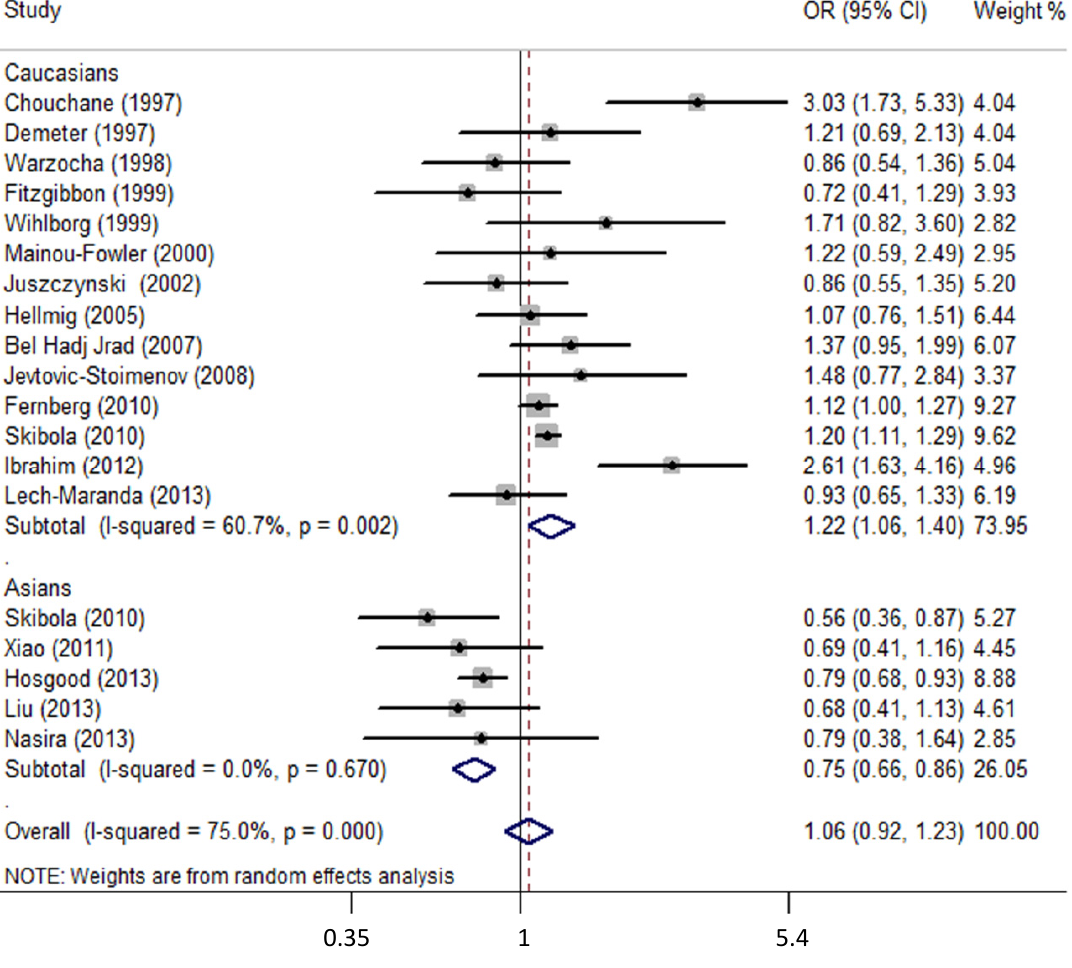
Figure 1. Overall association between TNF- α -308G>A polymorphism and NHL risk (additive model) in Caucasian and Asian populations. For each study, the estimate of odds ratio (OR) and its 95% confidence interval (CI) is plotted with a box and a horizontal line. The symbol diamond indicates pooled OR and its 95%